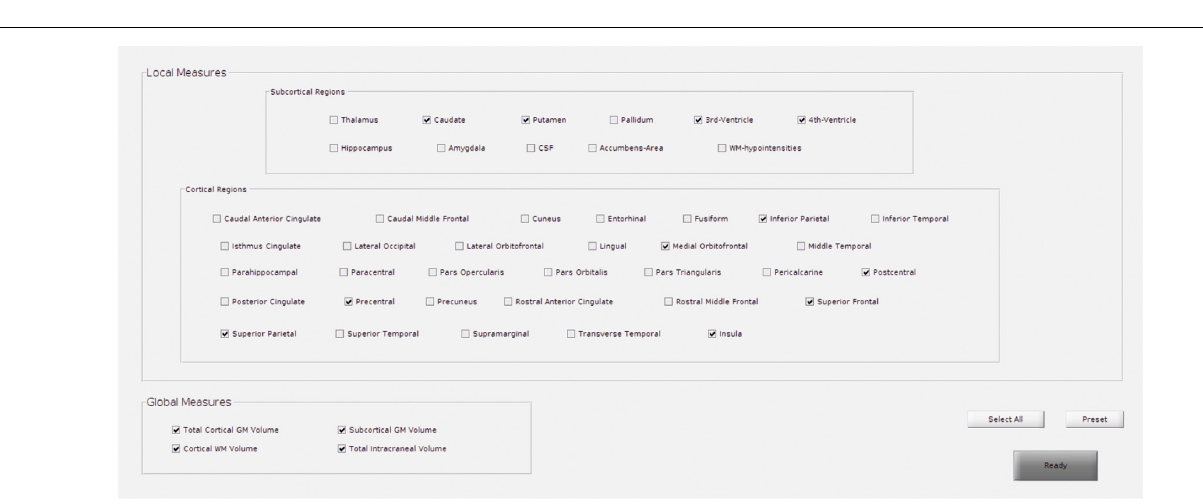
be also possible to take different potential confounding factors (such as gender, vascular health, years of education, etc.) into account by having a candidate control group matched for the selected factors when asked for selecting the folder that contains controls